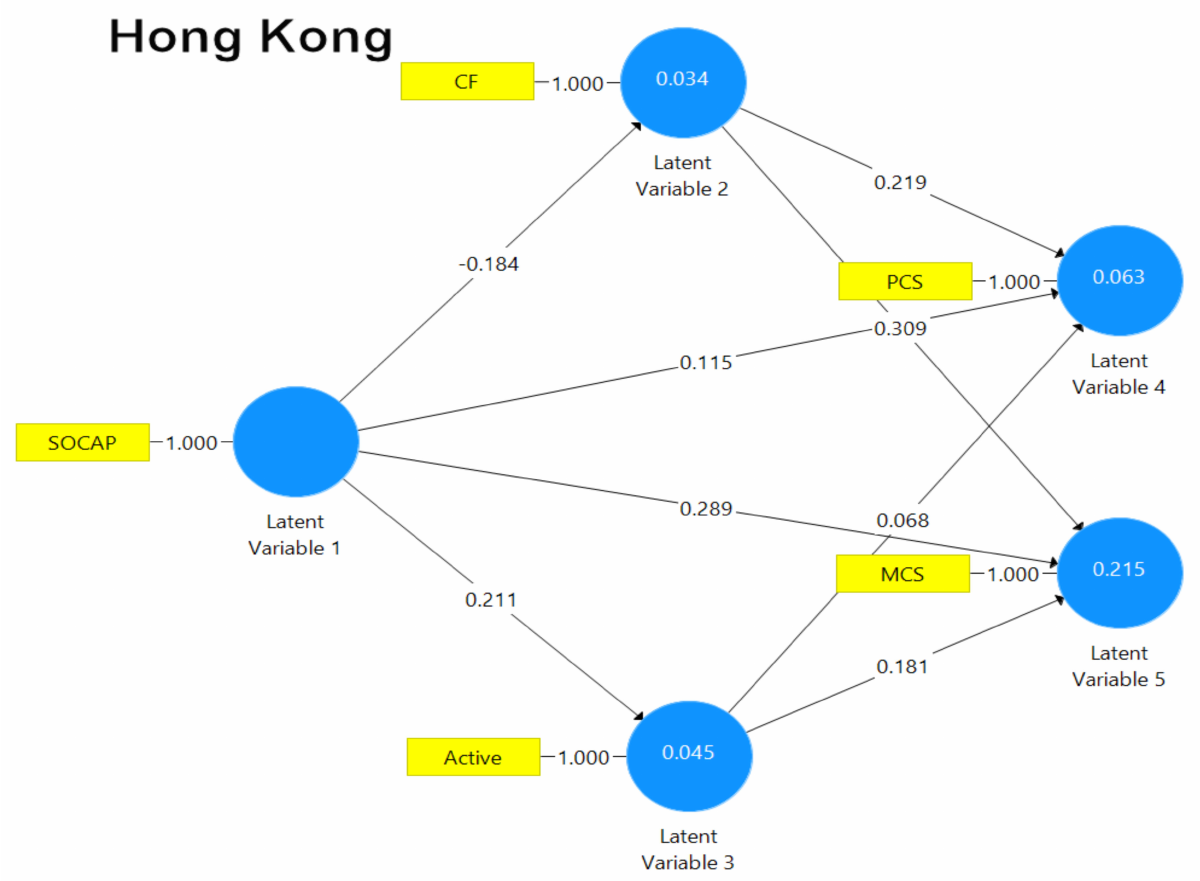
Figure 3. Diagram summarizing the path analytic findings of the Hong Kong sample. [Note. Active = active coping; CF = coping flexibility; MCS = mental health composite score; PCS = physical health composite score; SOCAP = social